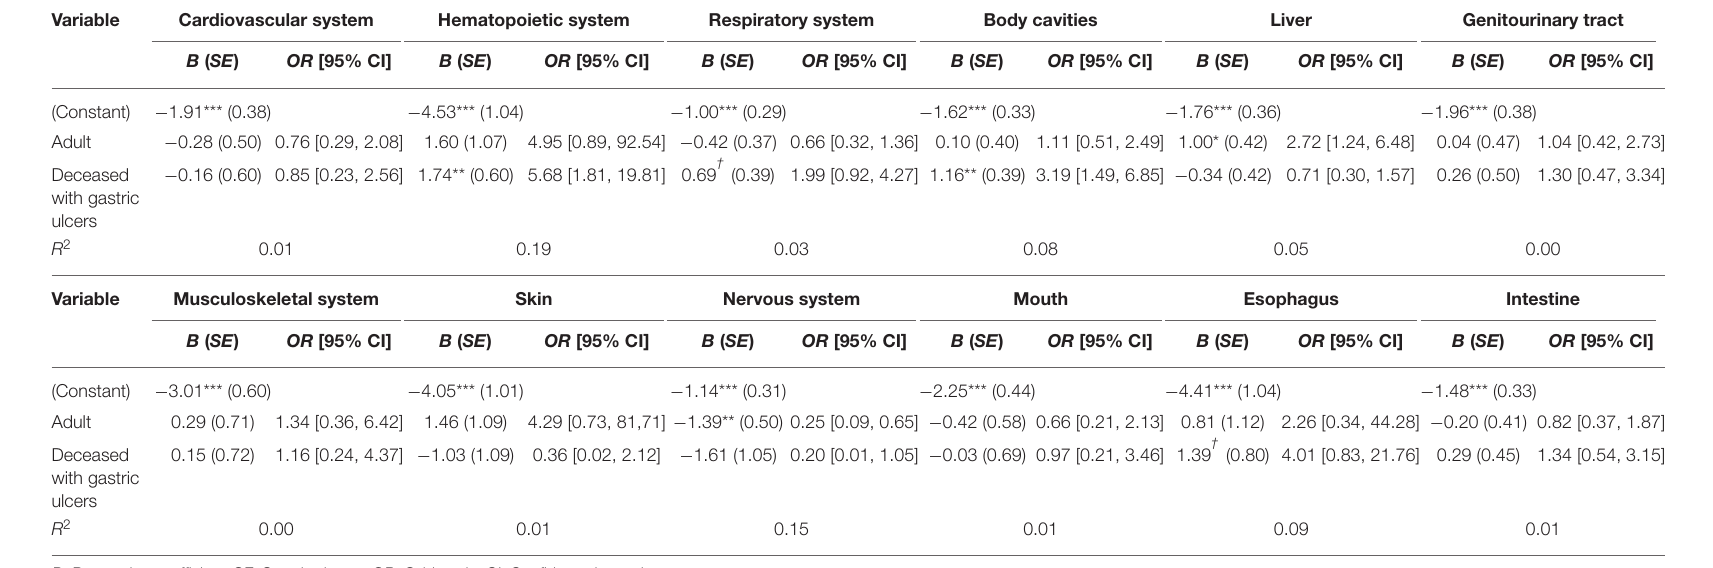
TABLE 4 | Multiple binomial regression estimation for clinically relevant affected organs/organ systems ( n = 187).